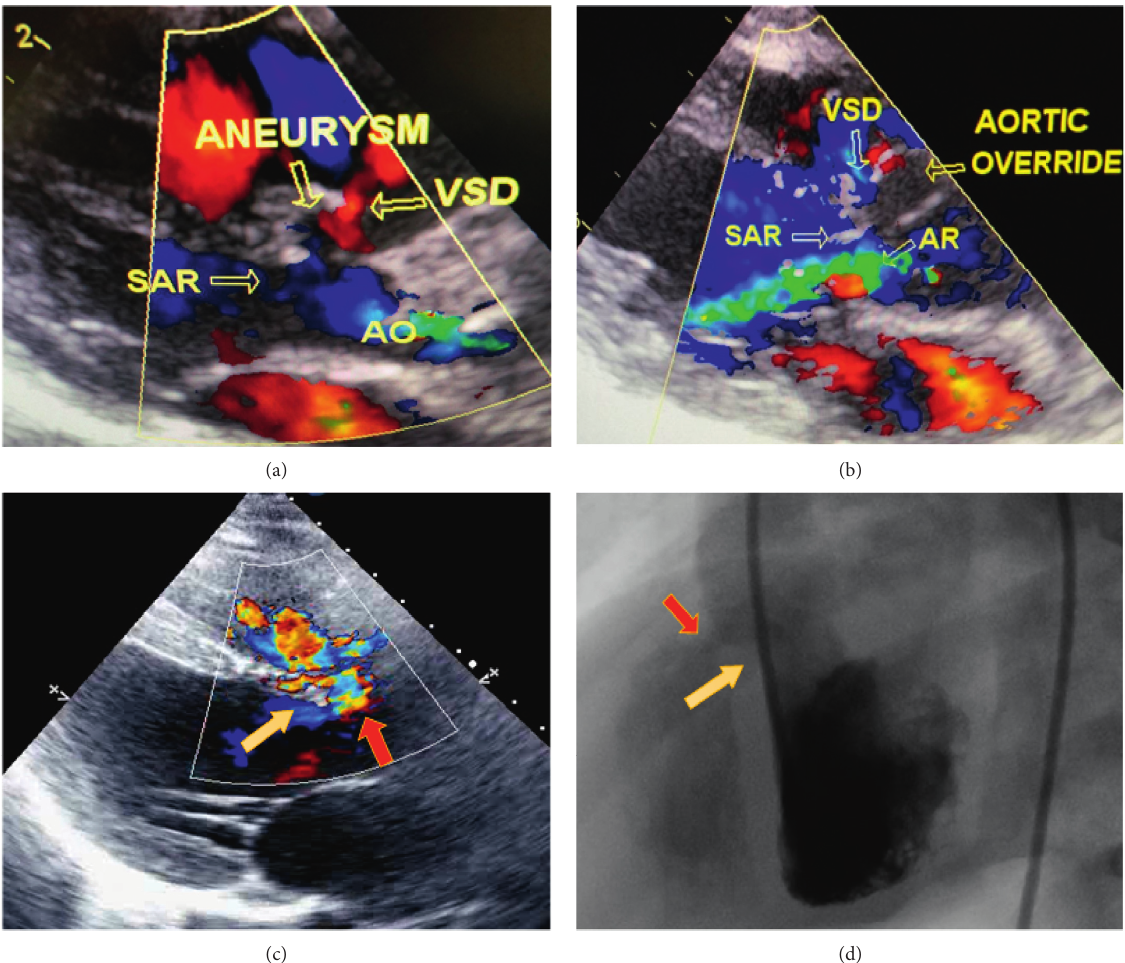
Figure 6: Exclusion criteria. (a) Echocardiographic parasternal long axis view with color flow mapping of a 10-year-old male patient demonstrated a moderately sized perimembranous subaortic VSD with septal aneurysm and subaortic ridge below the aneurysm and the VSD. (b) Cross-sectional echocardiogram in the long axis parasternal view with color flow mapping of an eight-year-old female patient demonstrating a moderately sized subaortic VSD abuting severely prolapsed RCC with significant subaortic stenosis (fibromuscular ridge) associated with a moderate-to-severe AR. (c) Cross-sectional echocardiogram in the long axis parasternal view of a 3.5-year-old male patient with two holes of perimembranous subaortic VSD (red arrow) with anterior deviation of the outlet septum into the right ventricle (yellow arrow) causing subaortic obstruction below the VSD. (d) Left ventricular angiogram in the left anterior oblique (70 ° ) and cranial (30 ° ) projection showing a moderate sized subaortic VSD (red arrow) with anterior deviation of the outlet septum into the right ventricle without compromising the right ventricular outflow tract (yellow arrow) producing an aortic override of 40% and subaortic obstruction below the VSD (narrow